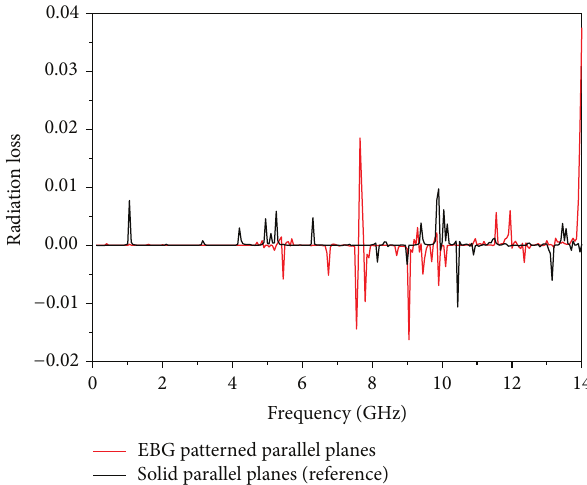
Figure 9: Material power loss 𝑃 defined in the caption of Figure 6.